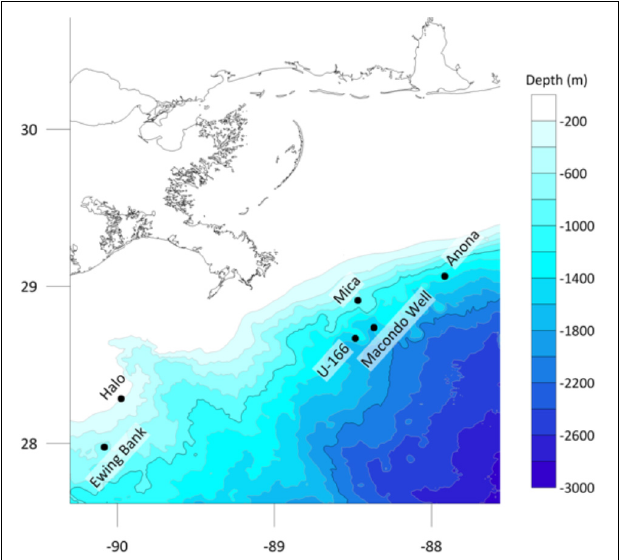
FIGURE 1 | Study sites in the northern Gulf of Mexico, and location of the Macondo wellhead.